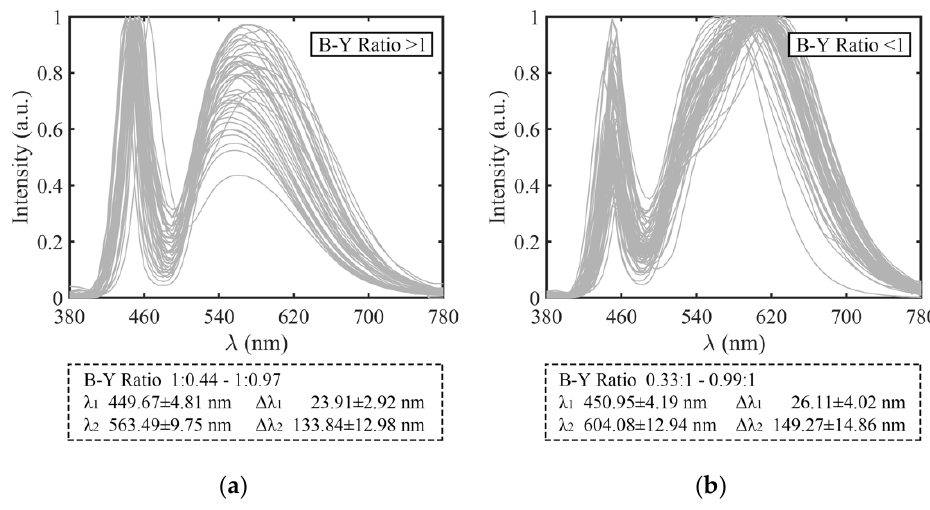
Figure 2. Spectra of phosphor-converted LEDs (PC LEDs) presented in IES TM-30-15 with different emission intensity ratios: ( a ) B:Y ratio > 1, ( b ) B:Y ratio < 1.